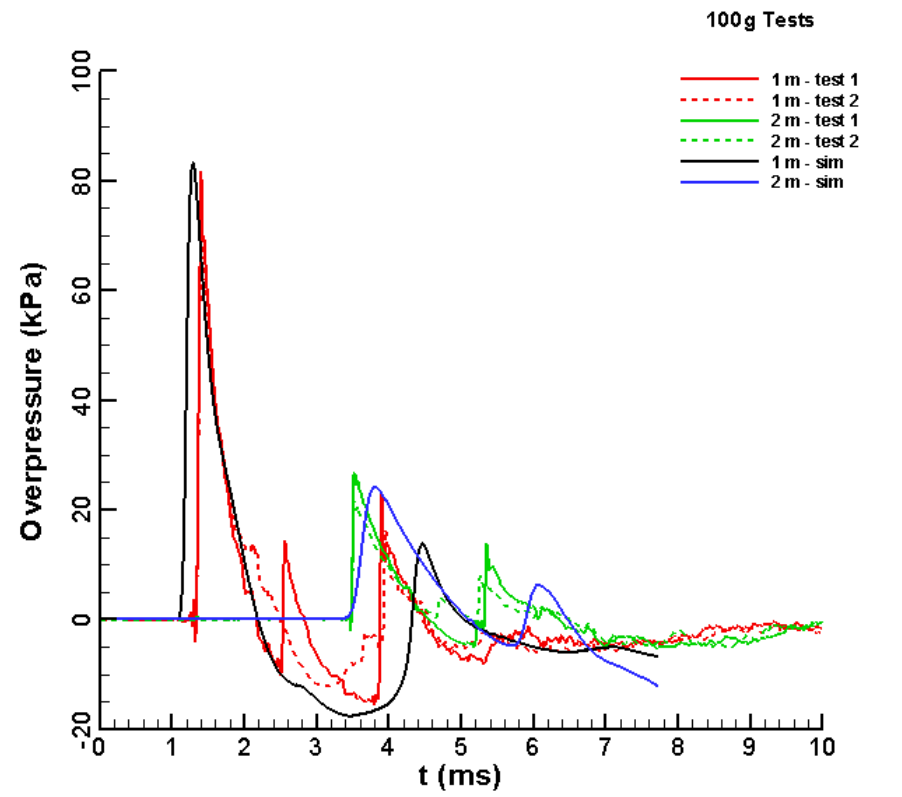
Figure 7. Comparisons between the test data and simulated values for the pressure versus time history at the 1- and 2 m locations for the 100 g charge.